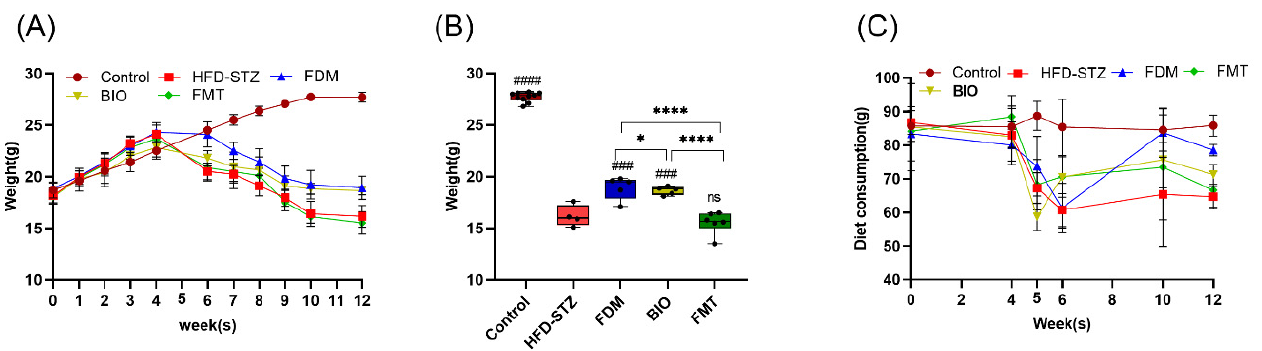
Figure 5. Effects of bacterial transplantation on weight and diet. ( A ) Body weight change curve during the intervention process. ( B ) Mice weight after intervention, in which the FDM group increased significantly ( p < 0.001). ( C ) Change curve of the diet consumption of 5 mice/week in the intervention process, which was restored to a relatively constant level from a diet with lower quantities of food following modeling. The number of mice in each group at the end of the experiment was as follows: control ( n = 10), HFD-STZ ( n = 4), FDM ( n = 5), BIO ( n = 5), and FMT ( n = 6). * ( p < 0.05), and **** ( p < 0.0001) represents the one-way ANOVA analysis with the